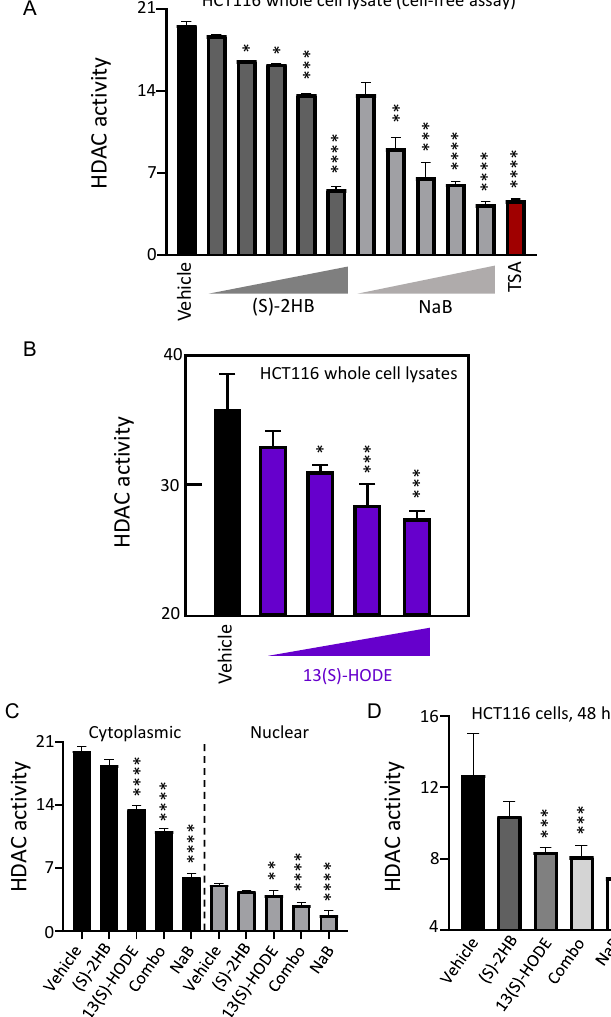
Figure 6. (S)–2HB and 13(S)–HODE are HDAC inhibitors. ( A ) Inhibition of HDAC activity in HCT116 whole cell lysates incubated with (S)–2HB or sodium butyrate (NaB); wedge symbol, 62.5, 125, 250, 500 and 1000 µ M; Trichostatin A (TSA) (0.1 µ M). ( B ) HDAC inhibition in HCT116 whole cell lysates incubated with 0.625, 1.25, 2.5 and 5 µ M 13(S)–HODE. ( C ) HDAC inhibition in cytoplasmic and nuclear extracts from HCT116 cells treated with 100 µ M (S)–2HB, 2.5 µ M 13(S)–HODE, 100 µ M (S)–2HB + 2.5 µ M 13(S)–HODE (Combo), or 1 mM NaB. ( D ) HCT116 cells were treated for 48 h with agents at concentrations used in ( C ), and whole cell lysates were tested for HDAC activity. Mean ± SD, n = 3, * p < 0.05; ** p < 0.01; *** p < 0.001; **** p < 0.0001. Y–axis, relative fluorescence units × 10 4